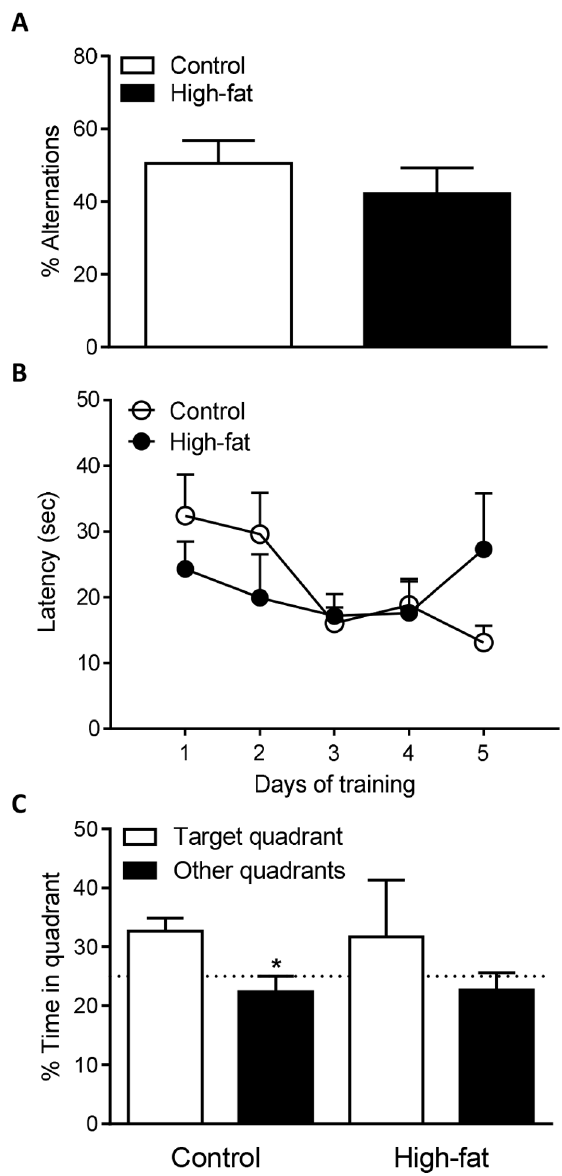
Figure 3. A high-fat diet during pregnancy and lactation impairs memory in female 3xTgAD offspring mice at 2 months of age. Memory was assessed in female 3xTgAD offspring mice using the Y-maze spontaneous alternation test (A) and the Morris water maze (MWM) test (B–C). For the MWM mice were given four trials a day for 5 d of submerged platform training (B). Twenty-four hours after the final trial mice were given a probe test with no platform (C). Data are mean 6 SEM for n =5 per group. * P , 0.05 versus the target quadrant for control fed group. further 4 min (phase 2). All behaviour was recorded with a camera (Sanyo Xacti VPC-C4, SANYO Fisher, CA) and MP4 video-clips were converted to an AVI format using Pazera MP4 to AVI converter 1.3 (Pazera-Software, PL). The duration (sec) spent exploring the objects was then measured using Observer 5.0